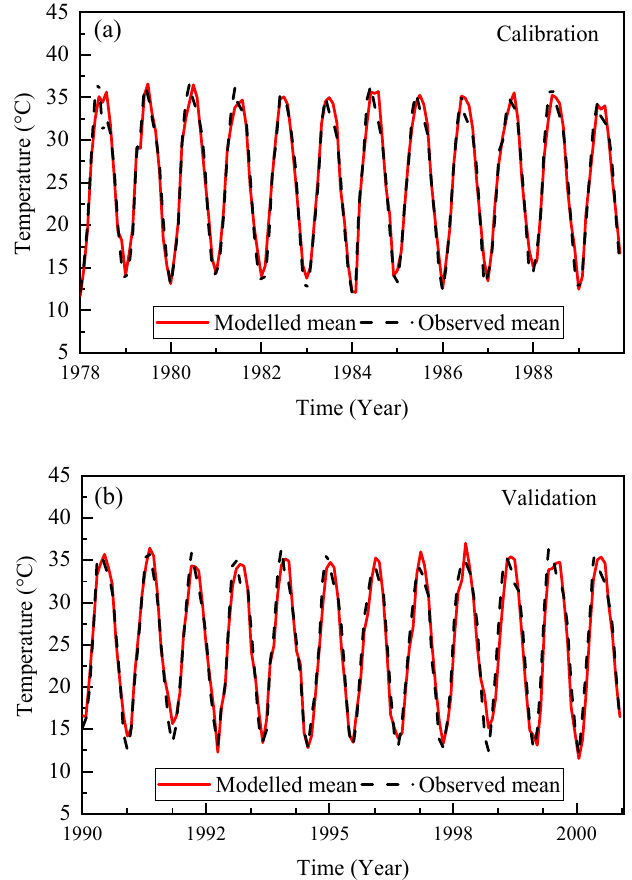
Figure 5. SDSM calibration and validation using NCEP and GCMs predictors, respectively, for monthly mean temperature: ( a ) calibration and ( b ) validation.